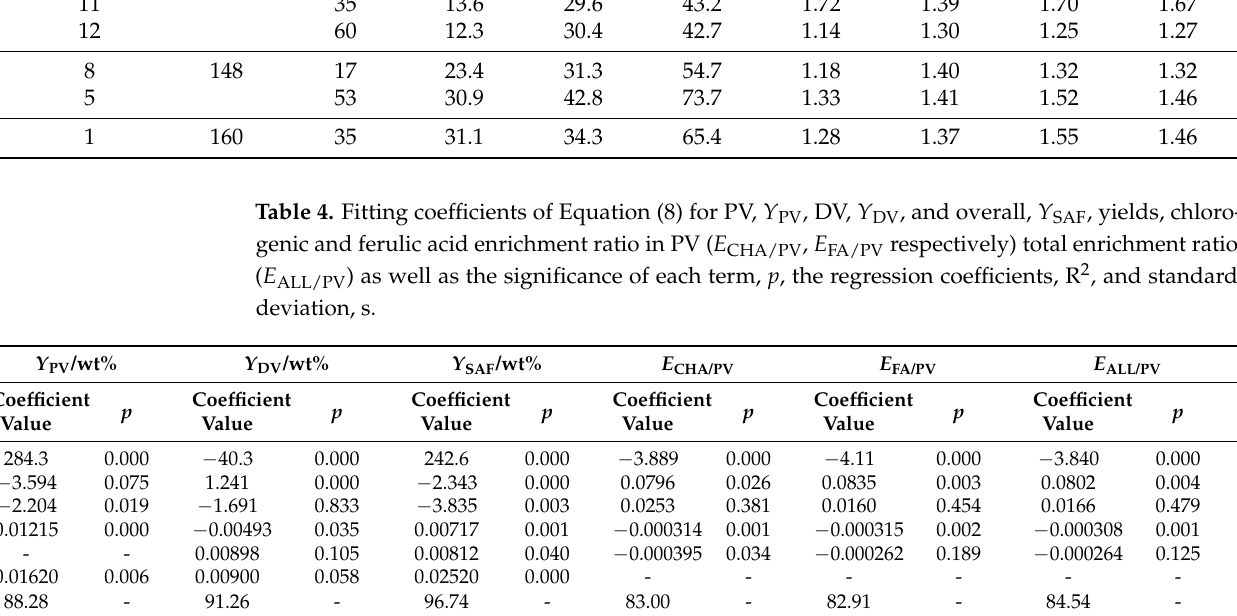
, for every run of the CCD 2